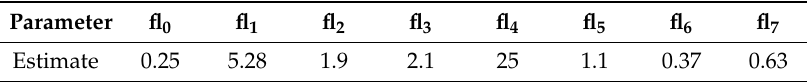
Table A2. Queuing delay parameters for Equation (10).